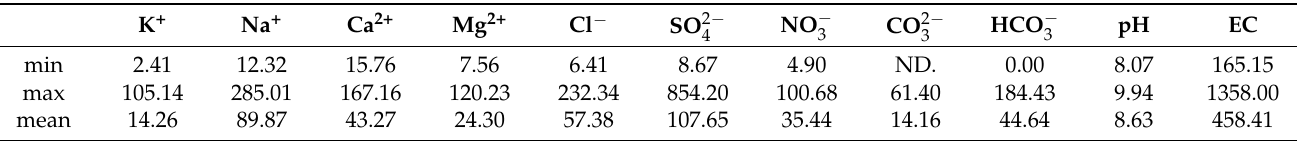
Table A2. Maximum, minimum, and mean values of anions and cations, pH, and EC of soil in Bayannur City.